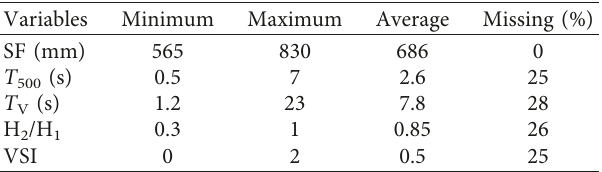
Table 2: Fresh state parameters after randomized removal of in- complete cases.